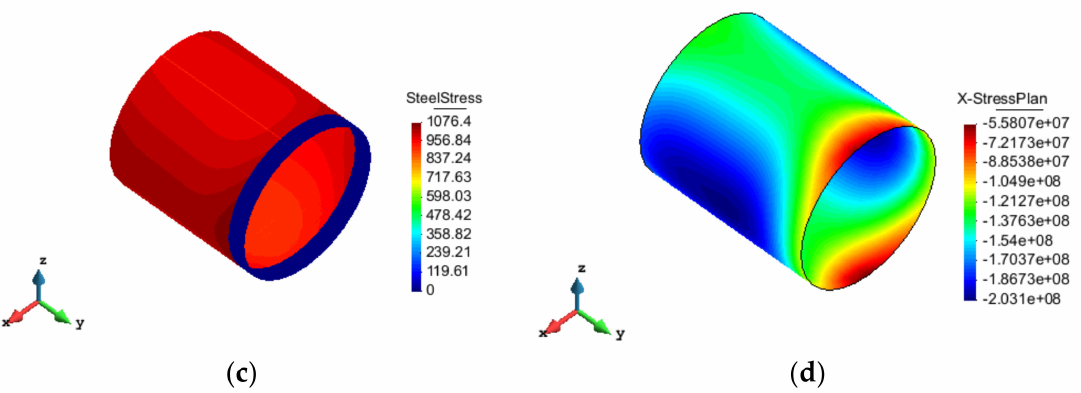
Figure 12. Nephogram of case 4: ( a ) damage, ( b ) 3rd principal stress, ( c ) wire stress, ( d ) cylinder stress.